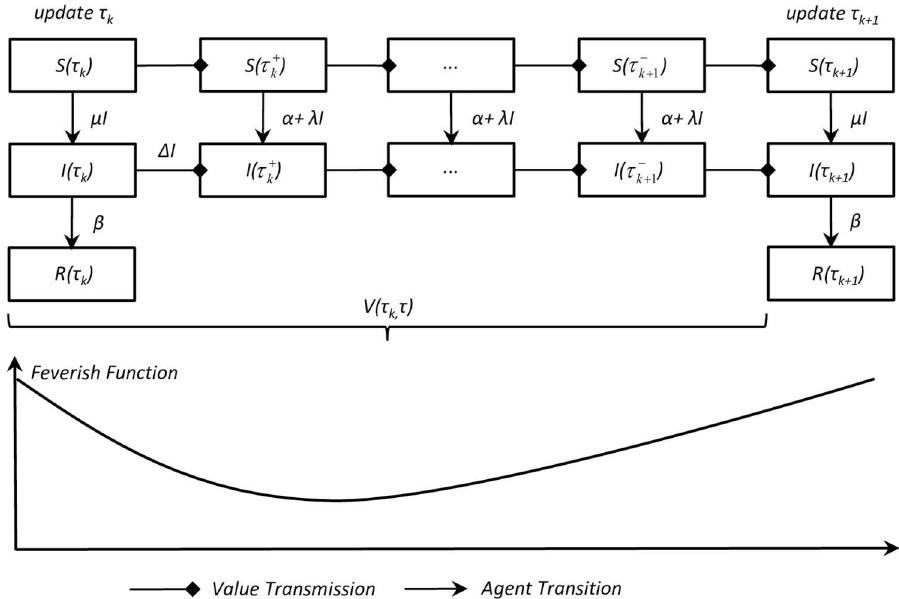
Þ is the audiencestopped k